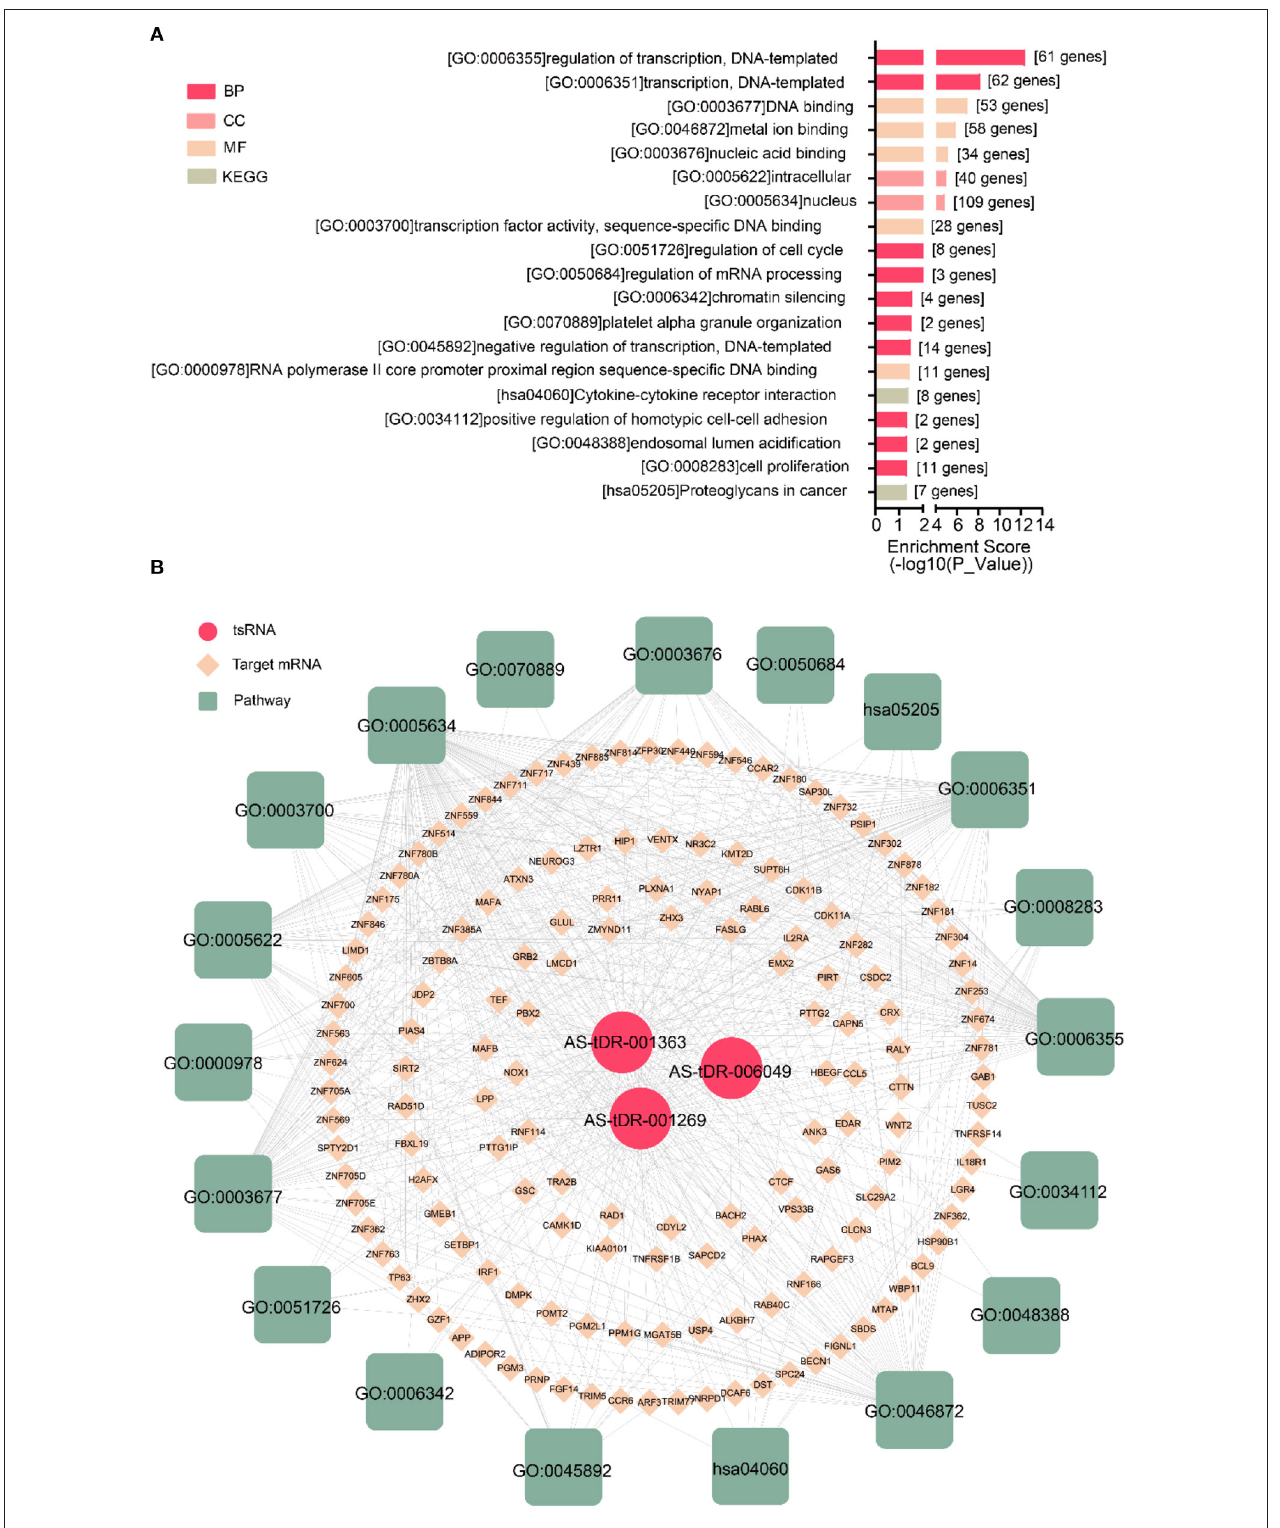
FIGURE 5 | Biological annotation of targets to reveal the function of altered tsRNAs. (A) The top 19 enriched terms were shown ranked by P _value. (B) The interaction networks of tsRNA-mRNA-pathway.